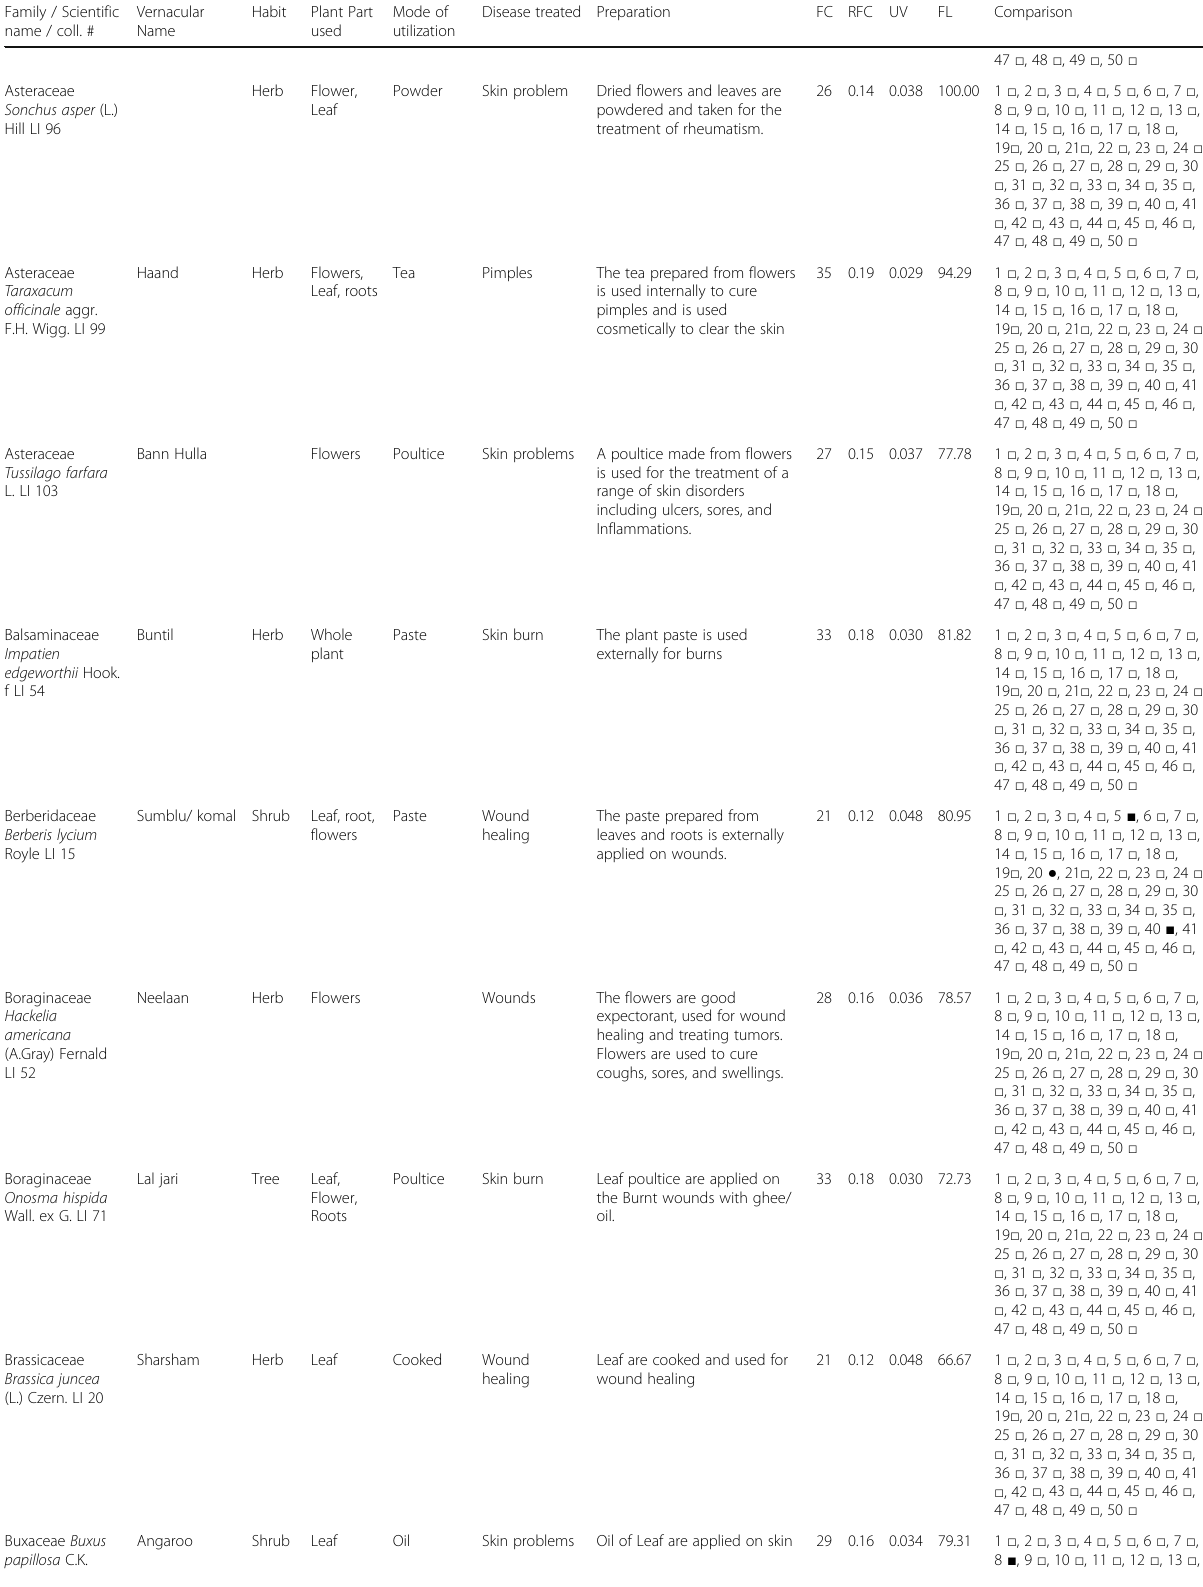
Table 2 Medicinal plants used for skin diseases in Northern Pakistan (Continued) Family / Scientific name / coll. # Asteraceae Sonchus asper (L.) Hill LI